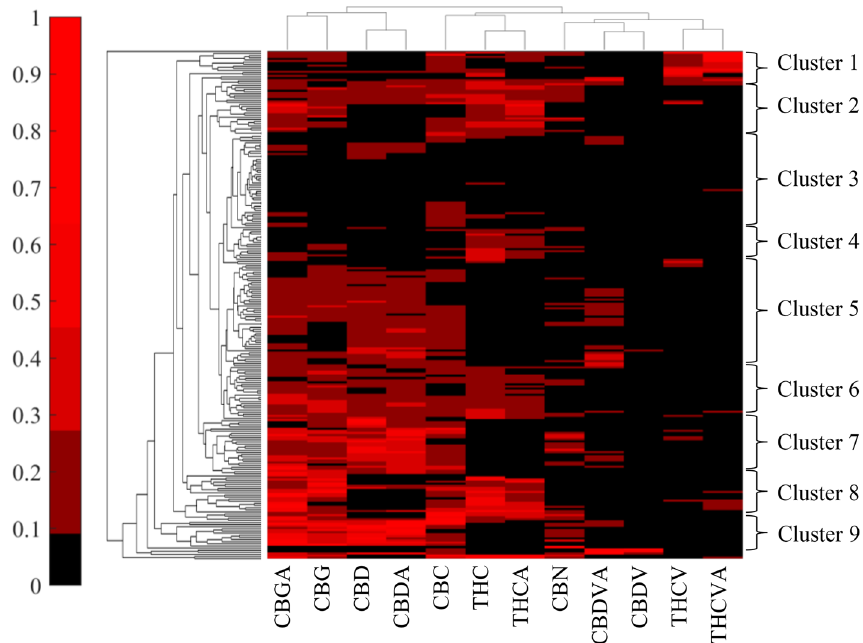
Figure 2. Hierarchical clustering of germplasm collection, normalised. The vertical dendrogram defines the relationship between samples/accessions, while the horizontal dendrogram defines the relationship between individual cannabinoids across each sample. Cannabidiolic acid (CBDA), Cannabidiol (CBD), Δ9-Tetrahydrocannabinol acid (THCA), Δ9-Tetrahydrocannabinol (THC), Cannabigerolic Acid (CBGA), Cannabigerol (CBG), Tetrahydrocannabivarinic acid (THCVA), Tetrahydrocannabivarin (THCV), Cannabidivarinic acid (CBDVA), Cannabidivarin (CBDV), Cannabinol (CBN), Cannabichromene